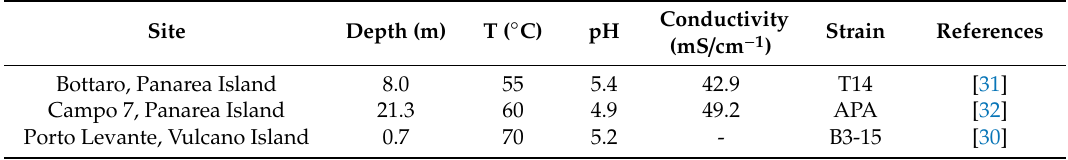
Table 1. Physicochemical characteristics of thermal fluids emitted from the shallow hydrothermal vents o ff the Eolian Islands and related isolated strains. Site Depth